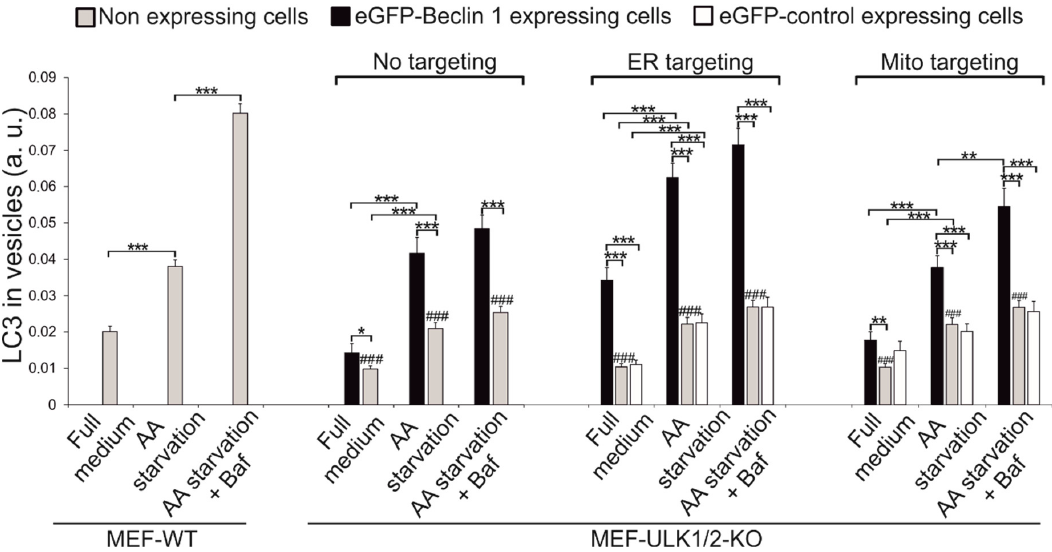
Figure 6. Quantification of LC3 labelling in MEF-WT and MEF ULK1 / 2-KO cells expressing the eGFP-tagged constructs. MEF-ULK1 / 2-KO cells were transfected with eGFP-Beclin 1-WT, eGFP-Beclin 1-ER, eGFP-ER, eGFP-Beclin 1-MITO, or eGFP-MITO. Cells were kept in full medium or starved in amino-acid (AA) free medium for 1 h with or without 100 nM bafilomycin A1, fixed and labelled with LC3 antibody. CellProfiler was used to quantify the proportion of LC3 in vesicles, both in cells expressing the eGFP-tagged constructs and in non-expressing cells in the same sample. Results are shown as mean and SEM of 50 eGFP-tagged construct expressing cells and 150 non expressing cells (N = 50 and N = 150, respectively). One-way ANOVA followed by Tukey Kramer post hoc test was used to test statistical significance. * p < 0.05, ** p < 0.01, *** p < 0.001 for comparisons within cell lines. ### p < 0.001 for non-expressing MEF-ULK1 / 2-KO cells compared to non-expressing MEF-WT cells under the same condition.